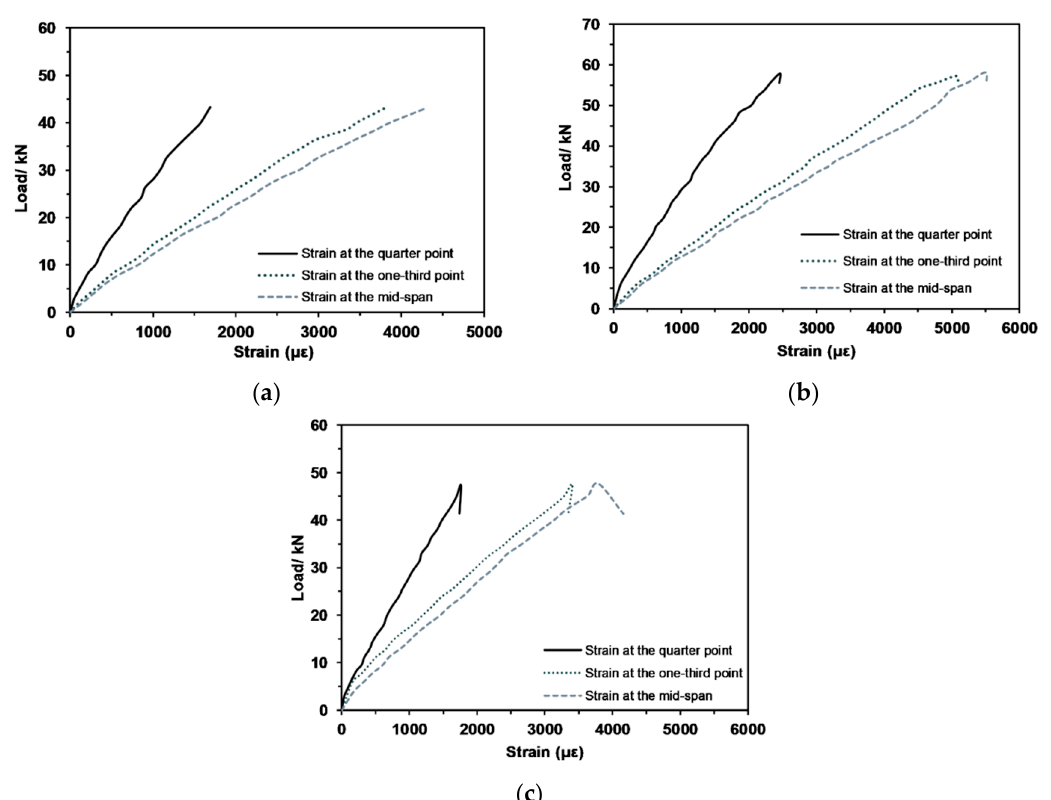
Figure 11. Strain curves of different sections in NCLT panels with different nail connections. ( a ) Polished rod nail NCLT panels; ( b ) Screwed NCLT panels; ( c ) Threaded nail NCLT panels.